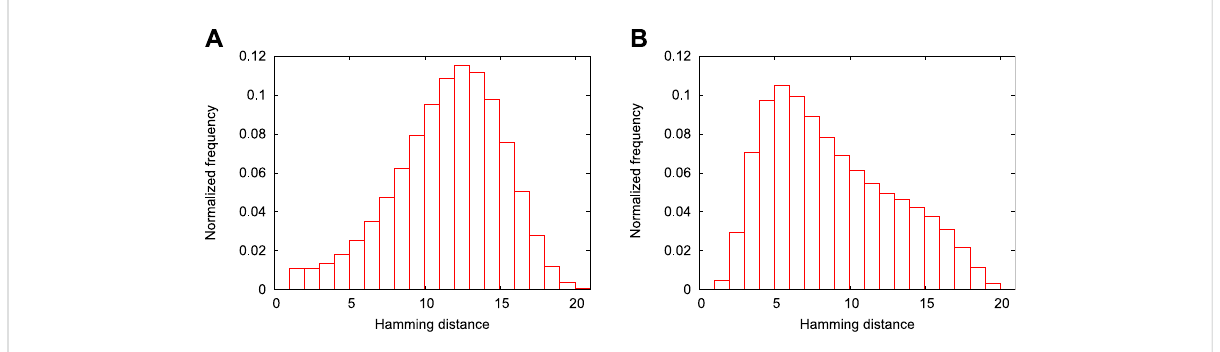
FIGURE 7 (color online) (A) Average of normalized frequencies of Hamming distances between the ground state con fi guration and all the fi rst excited states,overallthe100instancesof N =202SATproblems. (B) Sameas (A) exceptthattheprobleminstancesbelongtoclassofN=20RANproblems and that we only show the results for the 4,000 states which are closest to the ground state in energy. For the 2SAT problem considered, all the fi rst excited state are degenerate.